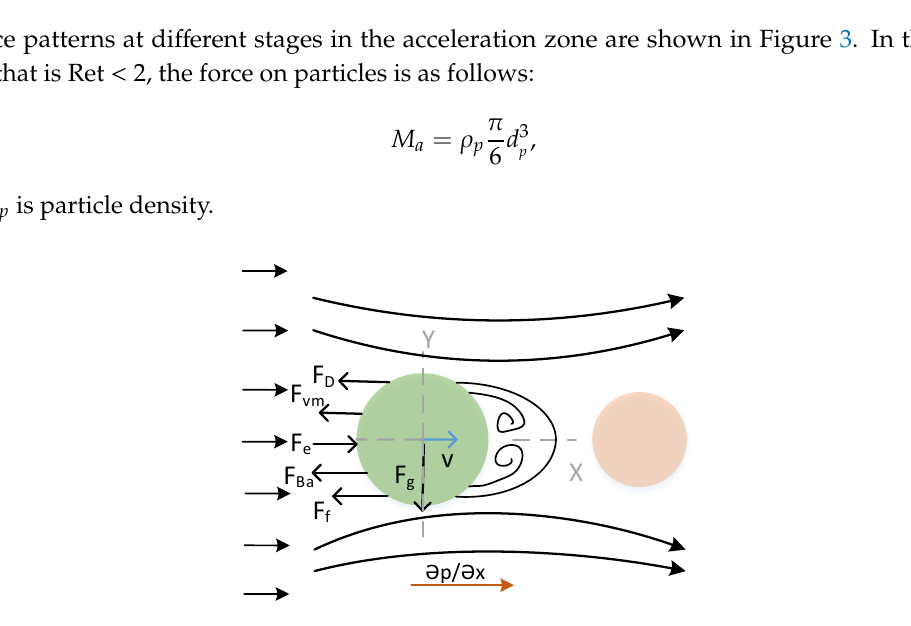
Figure 3. Particles force in accelerating electric field.